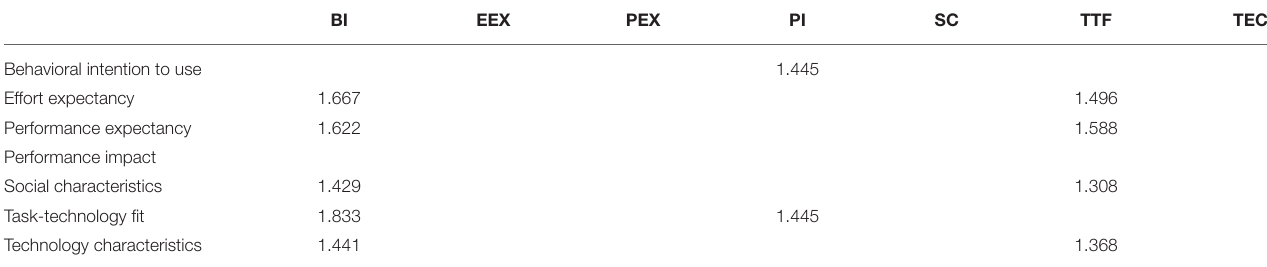
TABLE 7 | Variance inflation factor